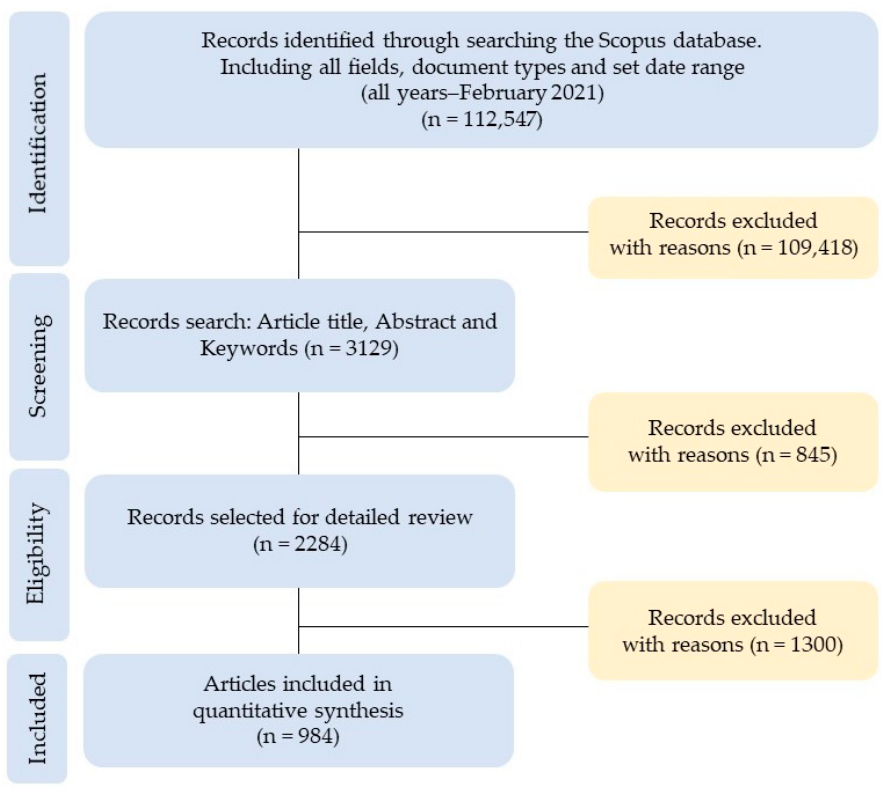
Figure 1. Selection of the sample of articles based on PRISMA.